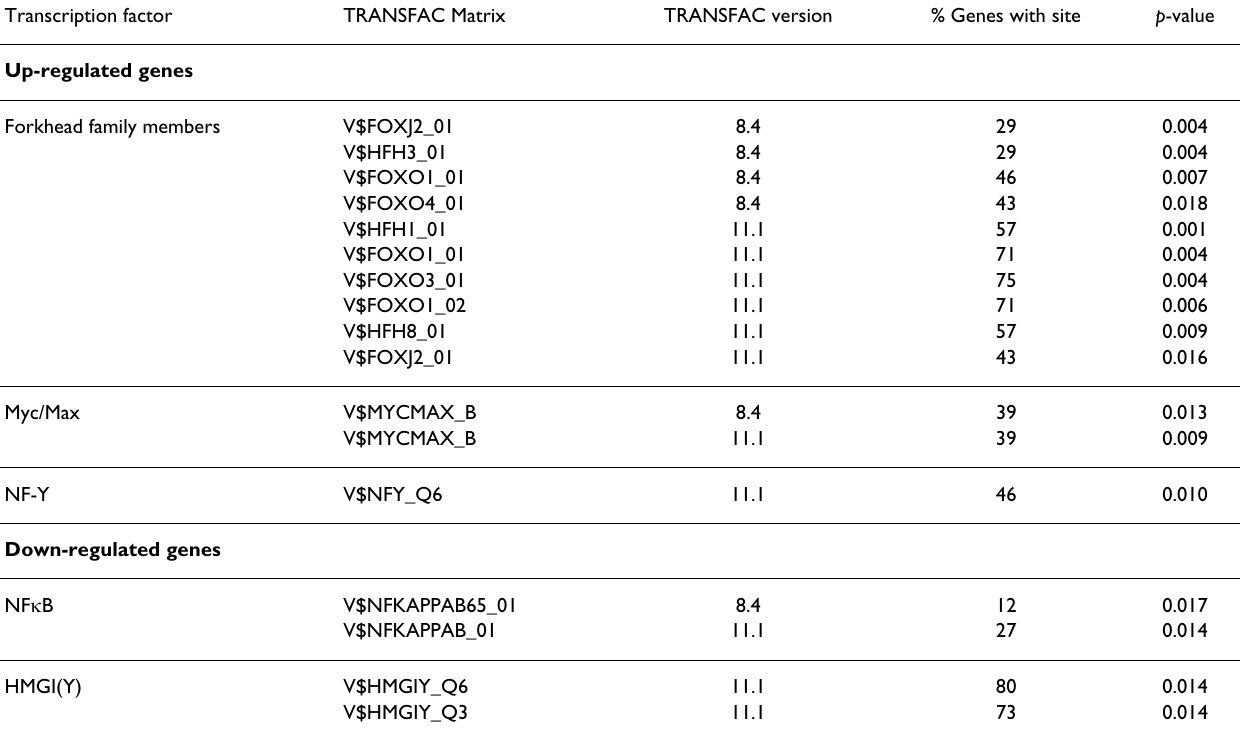
Table 4: Over-represented transcription factor binding sites in genes that were differentially expressed after PI 3-kinase inhibition. Transcription